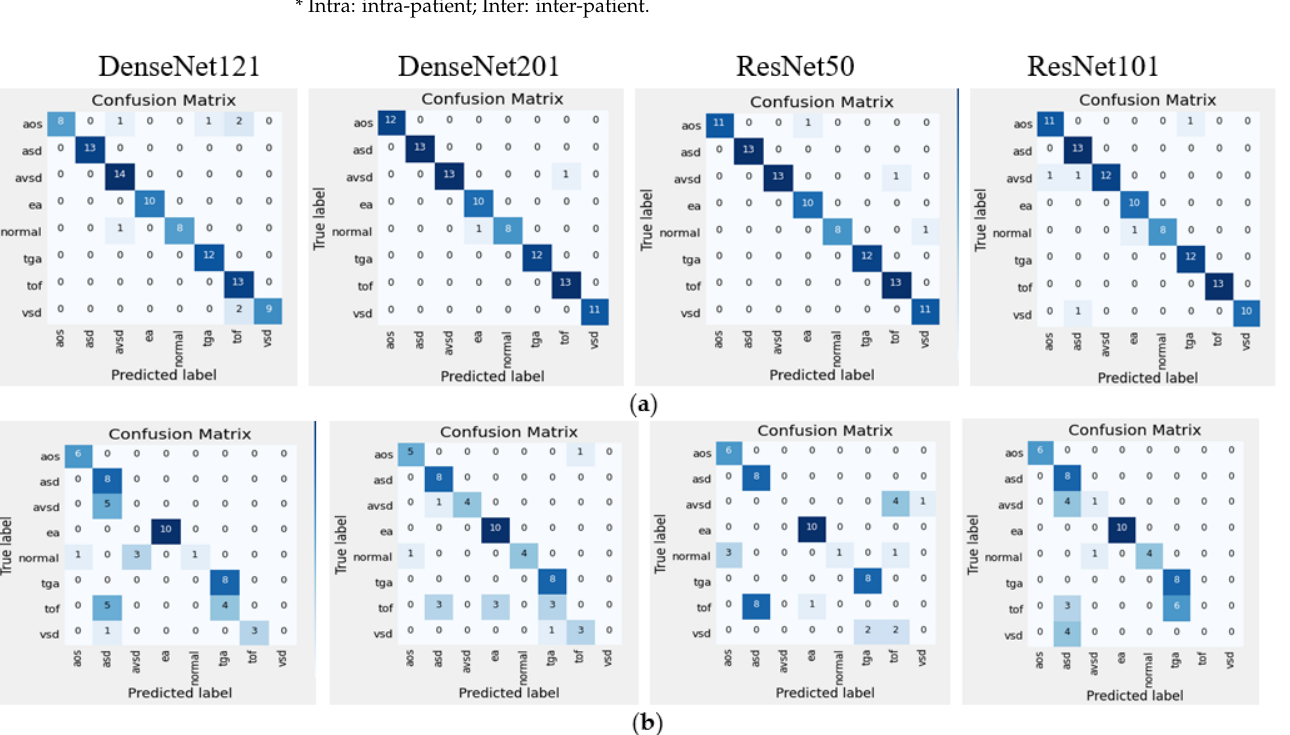
Figure 5. Confusion matrices of eight-class classification of four CNN classifier backbones based on intra-and inter-patient scenarios: ( a ) intra-patient validation; ( b ) inter-patient validation.